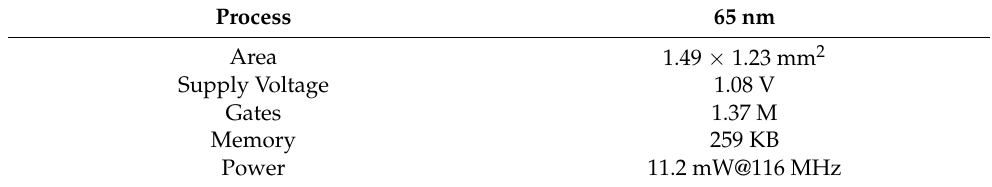
Figure 15. ( a ) SoC architecture and ( b ) a photo of the proposed NLO-CSM hardware accelerator’s demo for scan matching of an indoor corner based on a Zynq FPGA kit. Table 4. ASIC Implementation Results of the Proposed NLO-CSM Hardware Accelerator